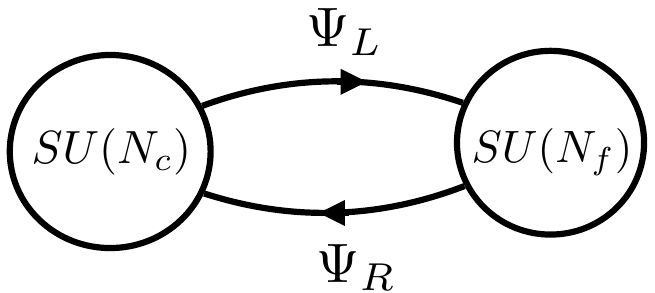
Figure 13 . Upon gauging SU( N f ) V , QCD(F) becomes a two site quiver theory (QCD(BF)) with 1-Dirac fermion, Z chiral and Z [1] 1-form symmetry. We must gauge Z [1] 1- 2gcd( N f ,N c ) gcd( N f ,N c ) gcd( N f ,N c ) form symmetry in order to turn on a background or gauge the faithful symmetry of the microscopic theory. There are intimate relations between the anomalies of the original multi-flavor QCD(F) theory and auxiliary QCD(BF)